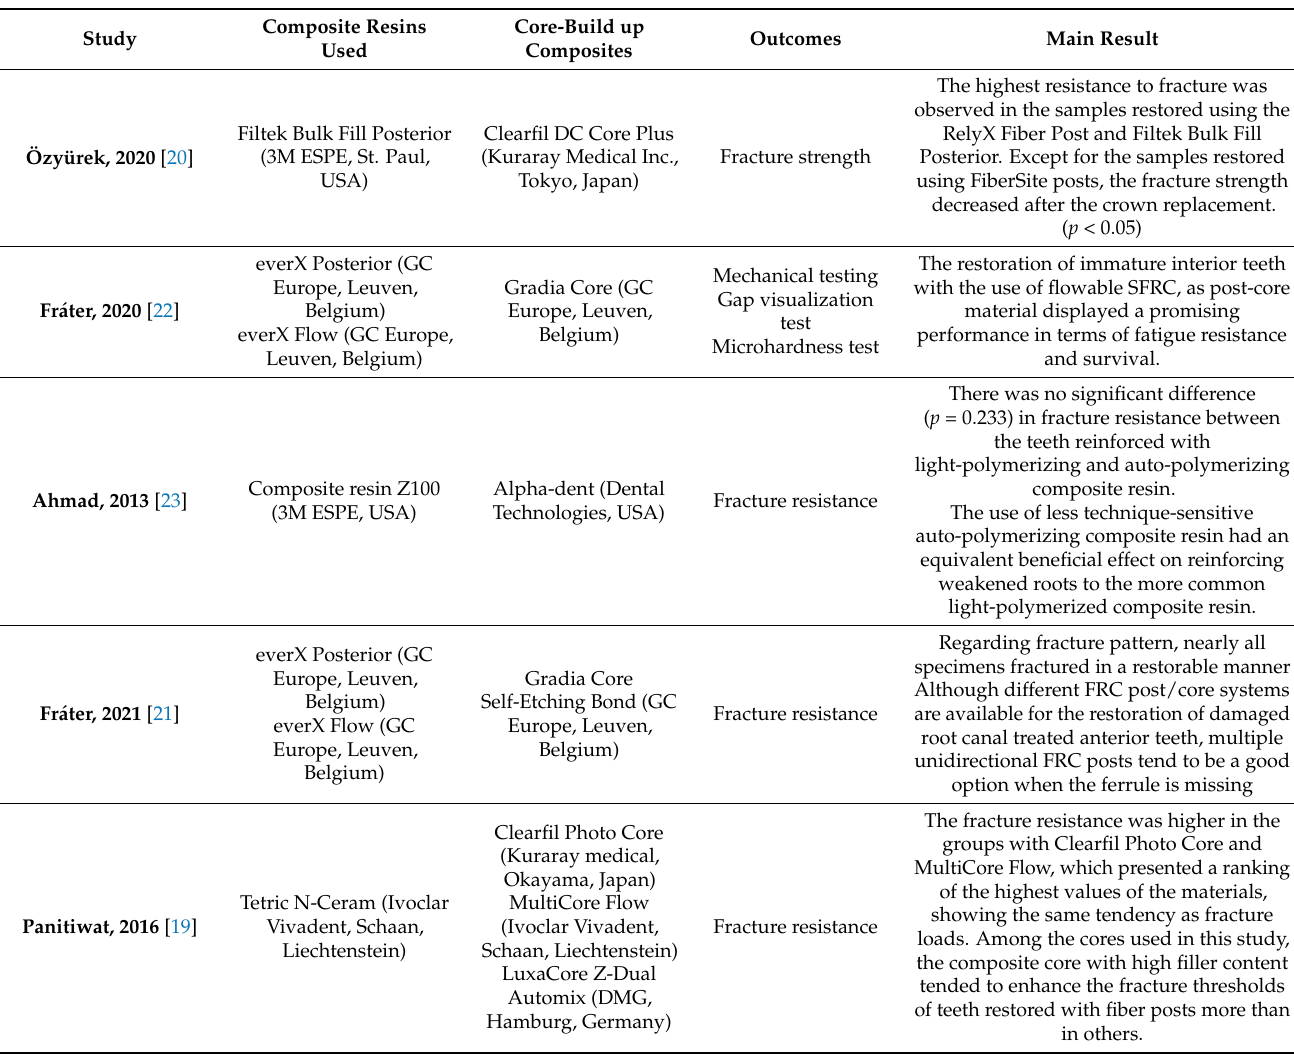
Table 2. Demographic and study design data of the included studies.